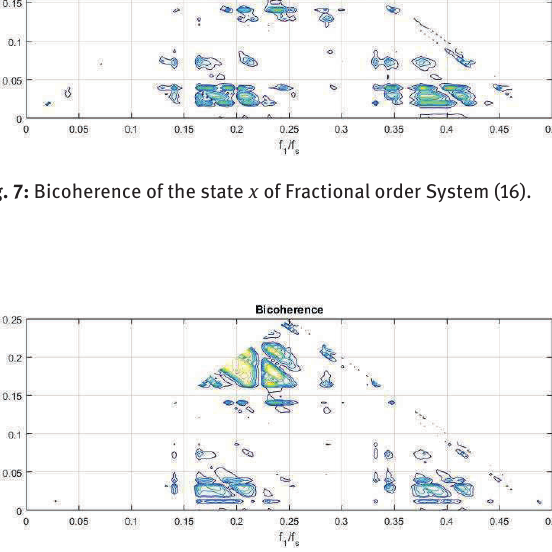
Fig. 8: Bicoherence of the state y of Fractional order System